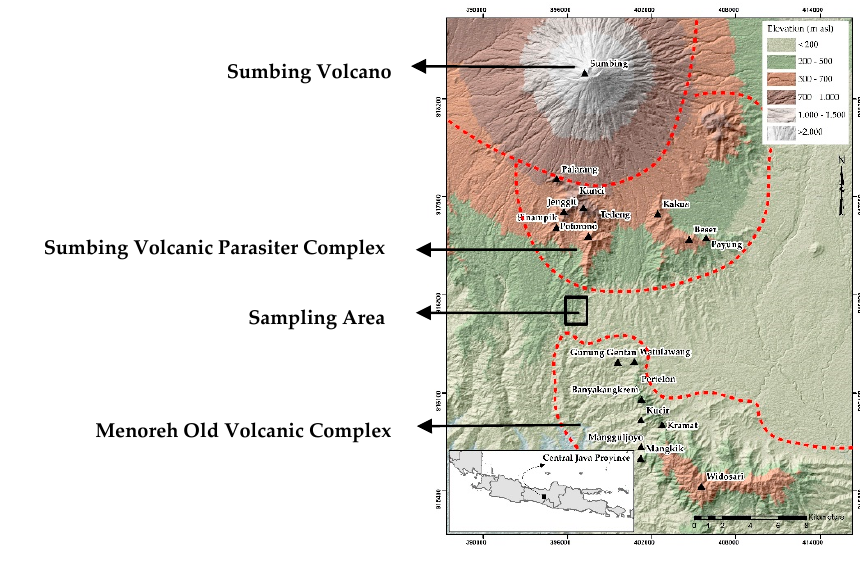
Figure 2. The research sampling location formerly experiencing landslide on the side of the erosion valley on the foot slope of Sumbing Volcano that is a transition area with the Menoreh Volcano complex.